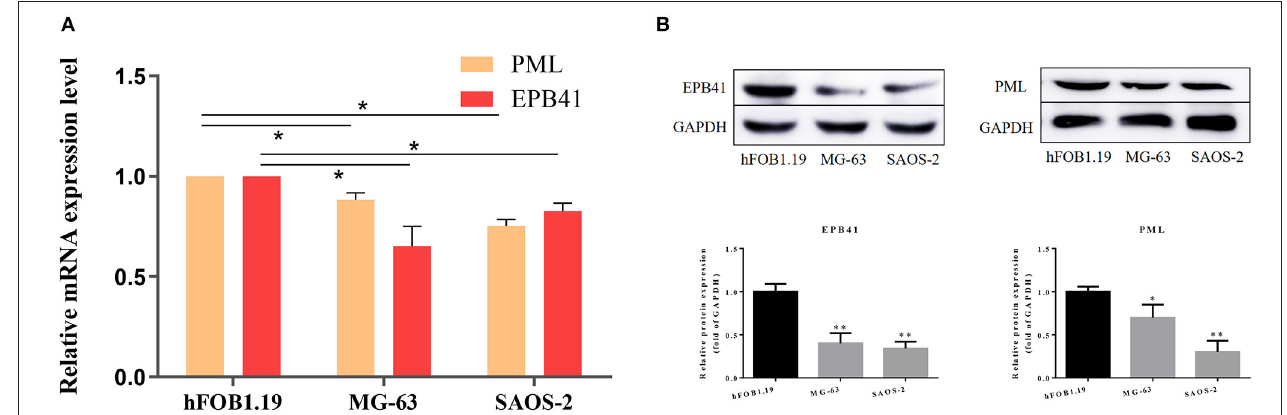
FIGURE 7 | (A) Relative mRNA expression level of PML and EPB41 in three cell lines are conducted by quantitative polymerase chain reaction. Data are presented as the mean ± SD. * P < 0.05 vs. hFOB1.19. (B) Expression of EPB41 and PML by western blot. Protein levels were statistically evaluated in columns. Measurements were in triplicate and data were presented as the mean ± SD. ** P < 0.01 vs.